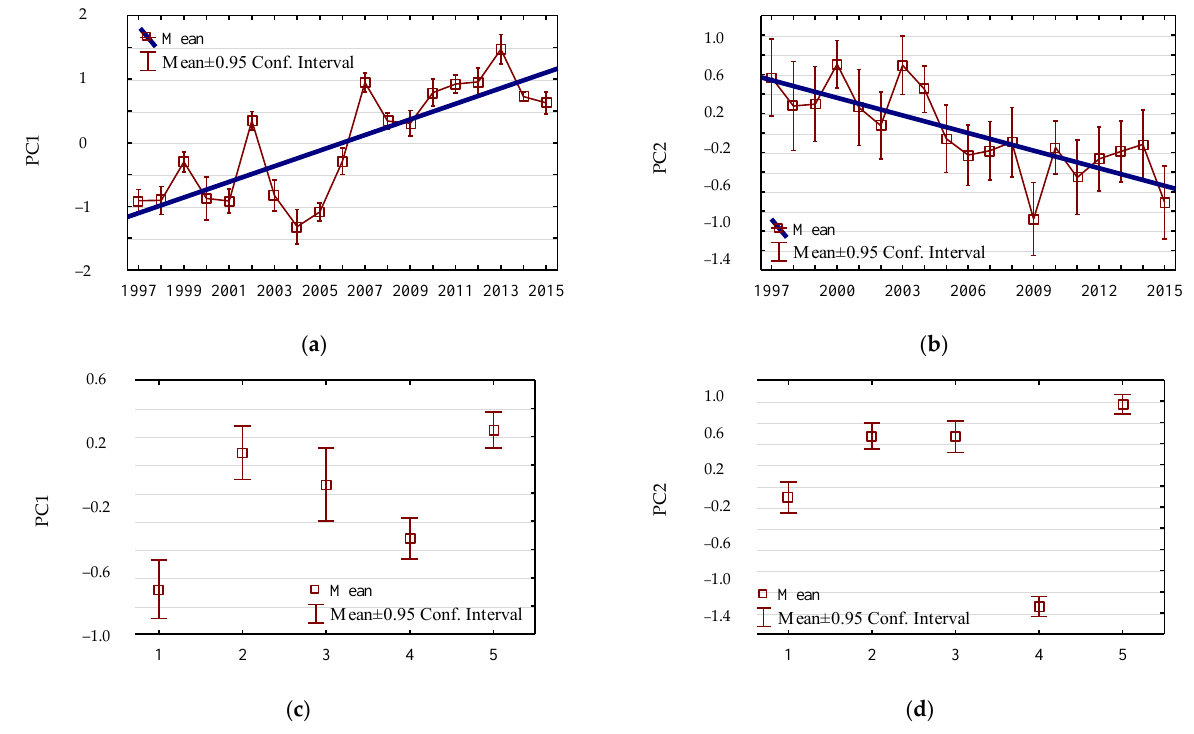
Figure 4. The dynamics of PC1 and PC2 (scores mean ± 95% confidence intervals). ( a , b ): the abscissa axis is years (1997 – 2015, the blue line shows a linear time trend); ( c , d ): 1 is the mouth of the Oril River, 2 are the water reservoirs of the Mykolaevka ledge system, 3 are the water bodies of the Obukhiv floodplain system, 4 is the water area of the Dnipro River channel part, and 5 are the water bodies of the Taromske ledge system.